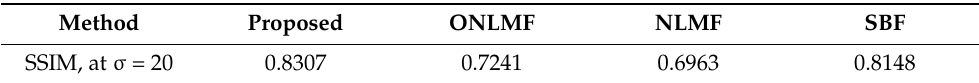
Table 2. SSIM values for several algorithms using clinical images. NLMF, non-local means filter; ONLMF, optimized non-local means filter; SBF, switching bilateral filter; SSIM, self-similarity index metrics; σ , Gaussian blur standard deviation.